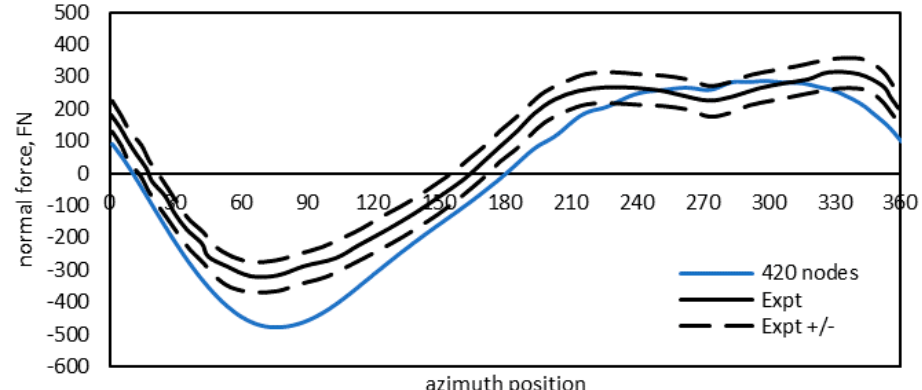
Figure 9. Airfoil normal force comparison between experimental data and CFD simulation across different azimuth positions.